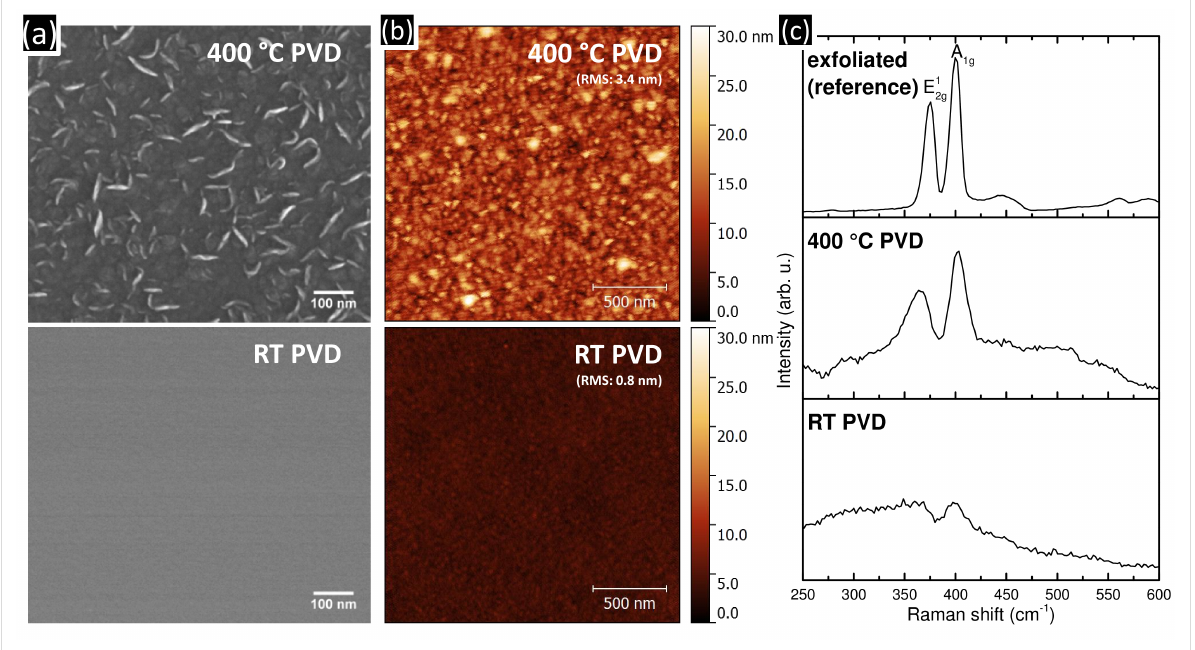
Figure 1: (a) SEM and (b) AFM images of MoS 2 thin films ( ≈ 100 nm) deposited at RT and 400 °C. (c) Ex situ Raman spectra of MoS 2 films deposited at RT (bottom, ≈ 1000 nm) and 400 °C (middle, ≈ 100 nm). The top spectrum was measured on an exfoliated MoS 2 crystal for